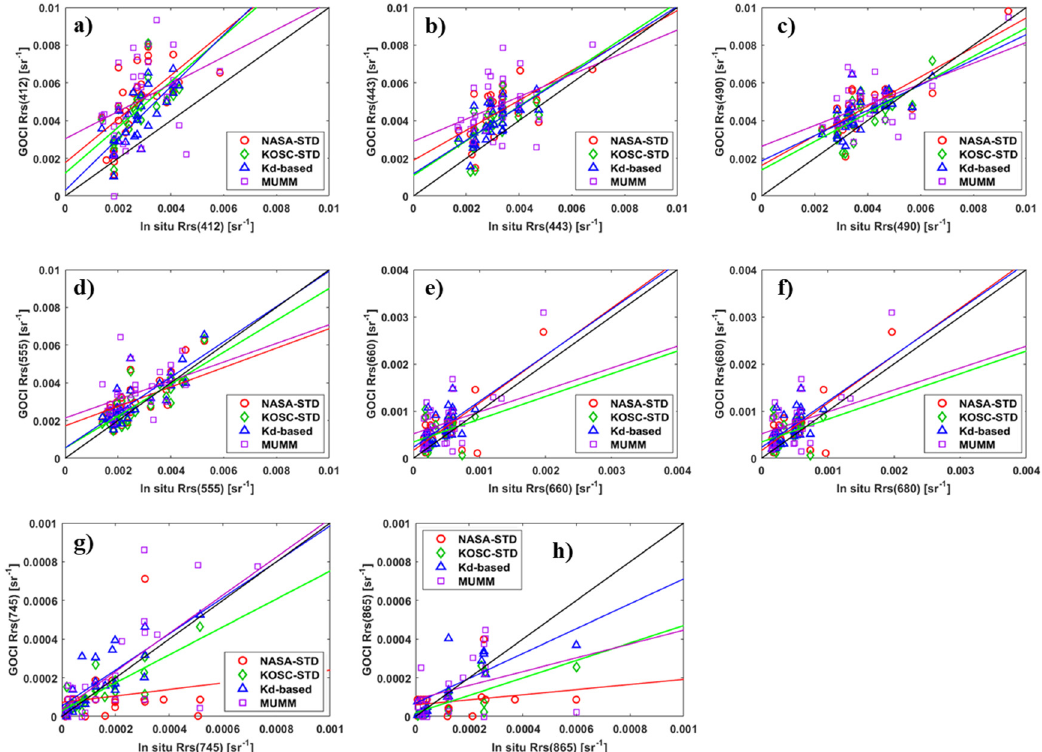
Figure 4. Scatterplots of GOCI Rrs retrieved using the four algorithms versus the in situ Rrs ( a – h ) at 02:16, 03:16, and 04:16 UTC within a ± 3 h match-up time for eight GOCI wavelengths. Red circles, green diamonds, blue triangles, and purple squares represent scatter points of NASA-STD, KOSC-STD, Kd-based, and MUMM algorithms, respectively, and red, green, blue, and purple solid lines are the corresponding fitted lines. The black solid line represents the 1:1 line. The difference between the GOCI-derived and the field-based Rrs data as a function of wavelength among the three GOCI overpass times is shown in Figure 5. The APD at 04:16 UTC is lower than at 02:16 and 03:16 UTC. The retrievals at Rrs(555) are the most accurate for the three overpass times for all four AC methods. The values of RMSE and Bias generally decrease with increasing wavelength. The lowest RMSE at 04:16 UTC occurs with the KOSC-STD method. Bias decreases quickly as wavelength increases from 412 to 490 nm, although it is nearly stable at wavelengths beyond 490 nm for all overpass times; this is especially true at 04:16 UTC.